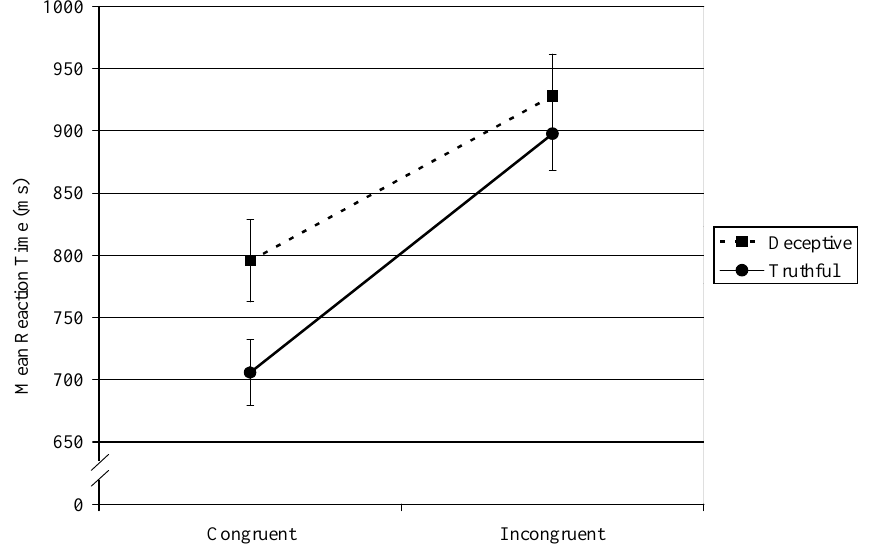
Fig.3. Mean reaction time in a two-stimulus paradigm in which both response deception and response congruity were predictable in Experiment